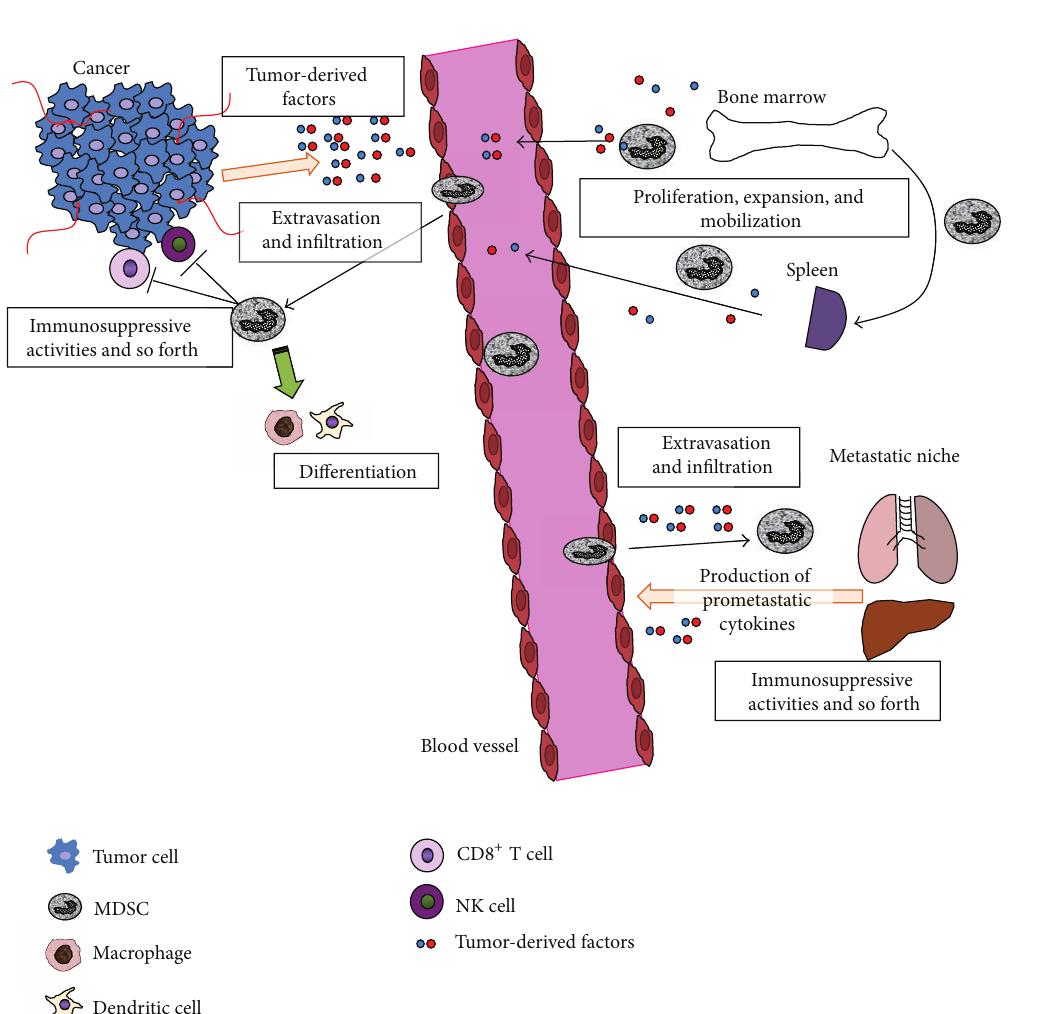
Figure 2: Schema of MDSC expansion and recruitment machinery. Tumor-derived factors (e.g., GM-CSF, IL-6, S100A8/A9, and PGE 2 ) promote proliferation, expansion, and mobilization of MDSCs from bone marrow hematopoietic progenitor cells, and tumor-derived chemokines (e.g., CXCL1/2 and CXCL12) recruit MDSCs to primary tumor and metastatic niche according to their chemokine gradients. Bone marrow-derived MDSC precursors are also arrested at marginal zone of spleen and migrate to the red pulp and proliferate. Recruited MDSCs support tumor progression by the immunosuppressive activities against cytotoxic CD8 + T cells and NK cells. M-MDSCs can differentiate to mature nonsuppressive dendritic cells or type 1 macrophages. MDSCs also facilitate tumor-associated angiogenesis and epithelial-mesenchymal transition of cancer cells, which results in invasion and extravasation. On the other hand, MDSCs can contribute to mesenchymal-epithelial transition at the metastatic